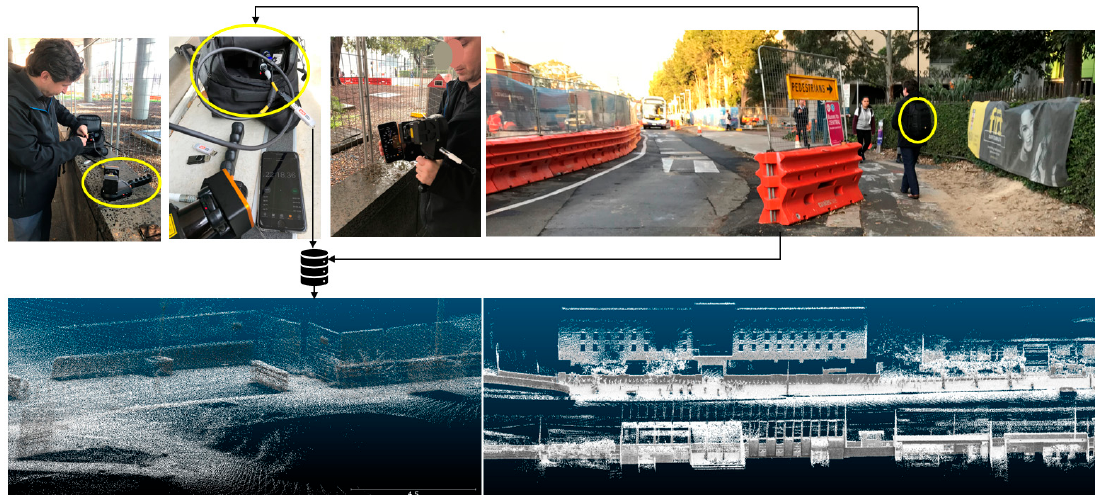
Figure 11. A case of multi-modal and multi-source data acquisition experimentation, including images and point cloud data using a camera and a selected handheld scanner from a light rail construction project.